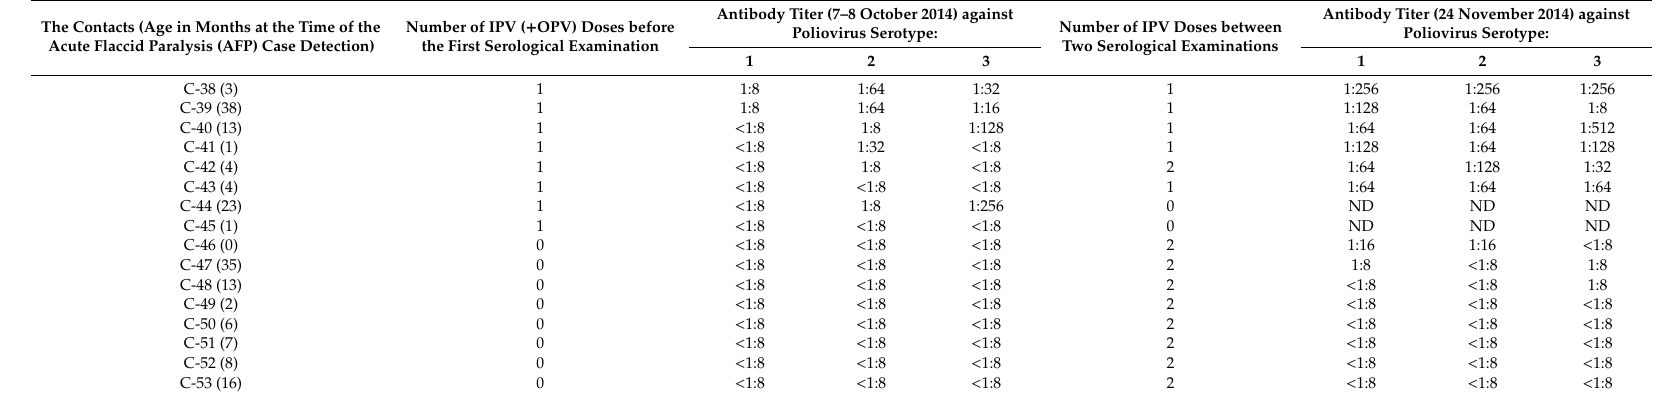
The Contacts (Age in Months at the Time of the Acute Flaccid Paralysis (AFP) Case Detection)